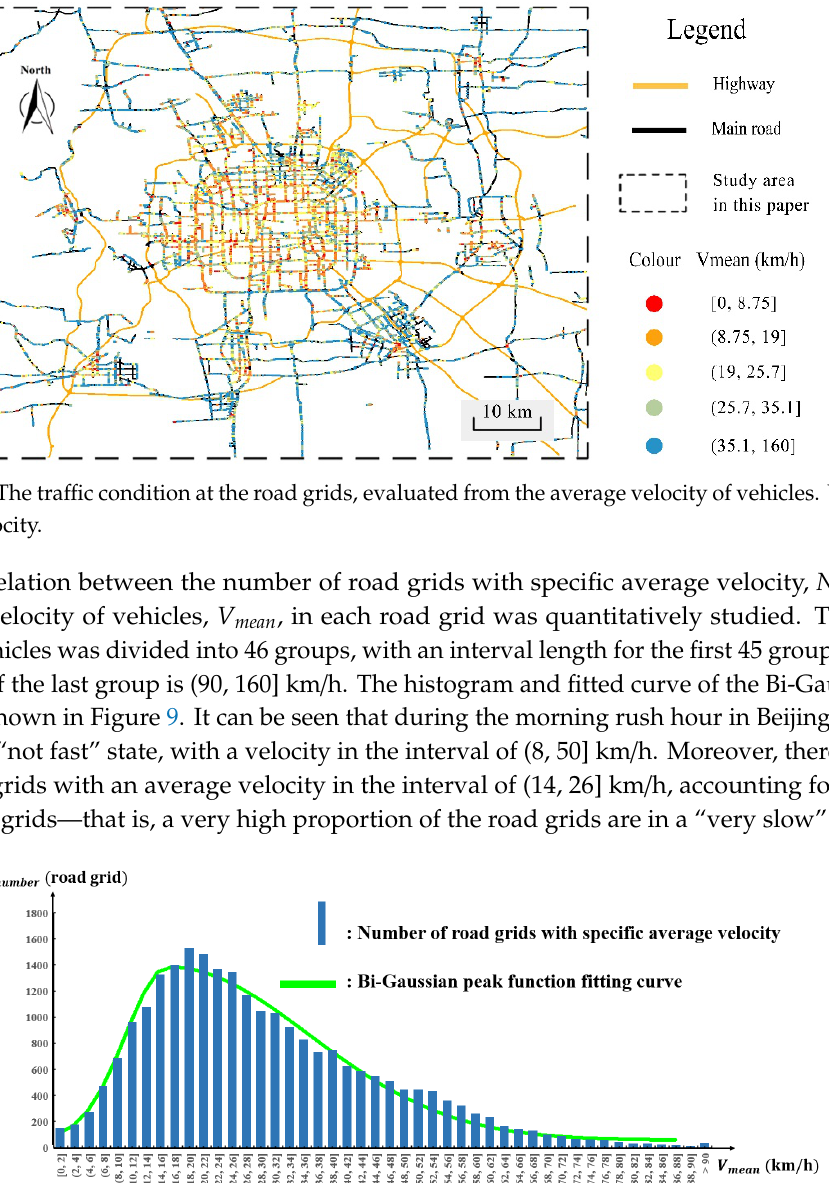
, , 𝑁𝑁 𝑛𝑛𝑛𝑛𝑗𝑗𝑛𝑛𝑛𝑛𝑟𝑟 𝑁𝑁 𝑛𝑛𝑛𝑛𝑗𝑗𝑛𝑛𝑛𝑛𝑟𝑟